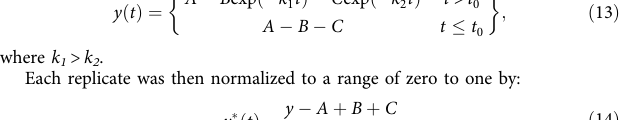
Supplementary Table 1. All oligonucleotides were resuspended in nuclease-free water and stored at − 20 °C. All experiments were performed in triplicate experi- ments unless otherwise noted.